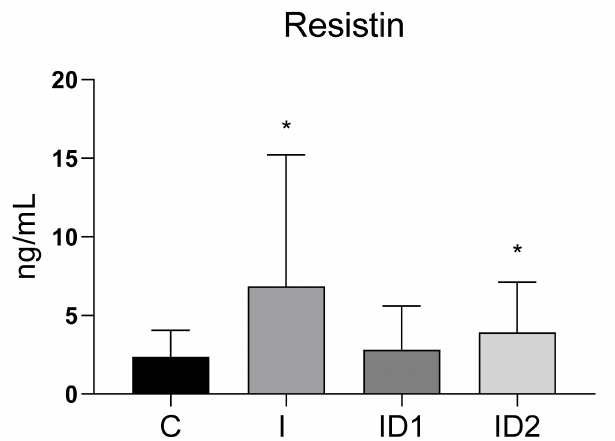
Figure 1. Plasma resistin concentration (ng/mL) in the different groups. Control group (C) n = 14, inflammatory group (I) n = 21, mild insulin dysregulation group (ID1) n = 18, severe insulin dysregu- lation group (ID2) n = 19. Bars represent mean + SD. Asterisks indicate significant differences with the control group (* p <